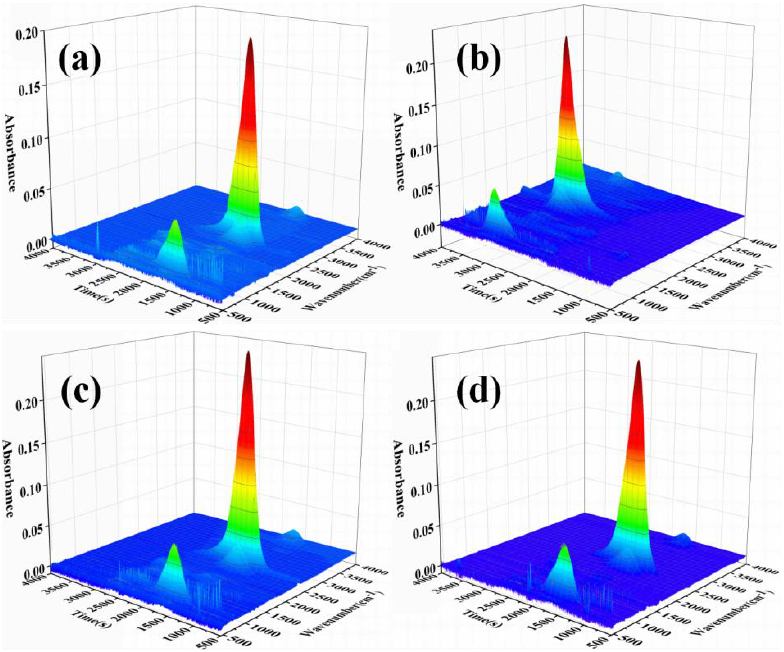
Figure 10. 3D TG-FTIR spectra of thermal decomposed compounds of ( a ) PBa, ( b ) PBa/PD-fu-1%,